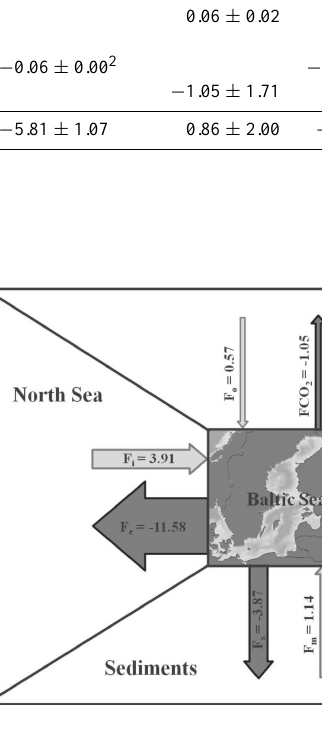
Fig. 3. Carbon budget of the Baltic Sea. Sources are marked in green (positive values), whereas sinks are marked in blue (negative values). Symbols: F e – export to the North Sea, F i – import from the North Sea, F o – atmospheric deposition, F CO 2 – net CO 2 ex- change between seawater and the atmosphere, F f – fisheries, F p – point sources, F r – river input, F s – accumulation in sediments, F m – return flux from sediments to the water column. All carbon fluxes are expressed in Tgyr − 1 (Tg=10 12